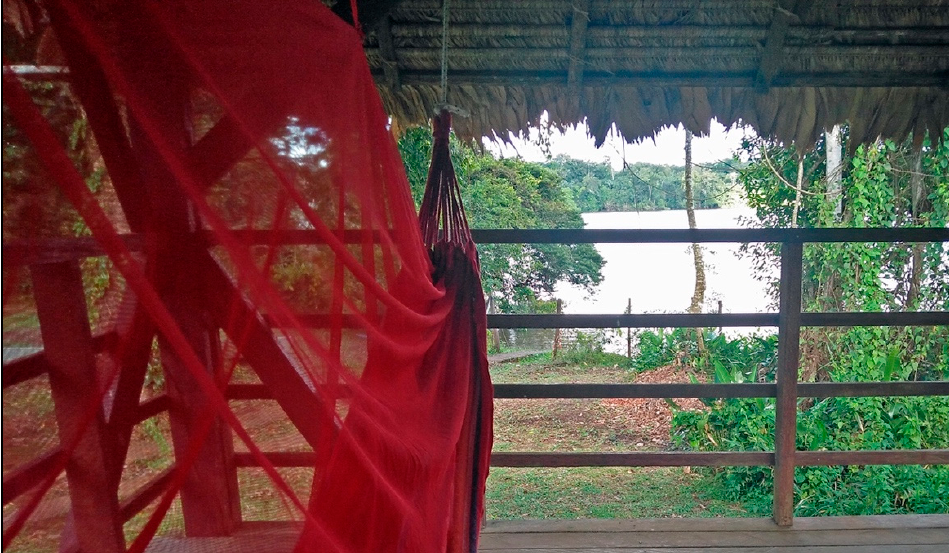
Figure 5. Carbet / Shelter accommodation in Maripasoula (Source: Luc